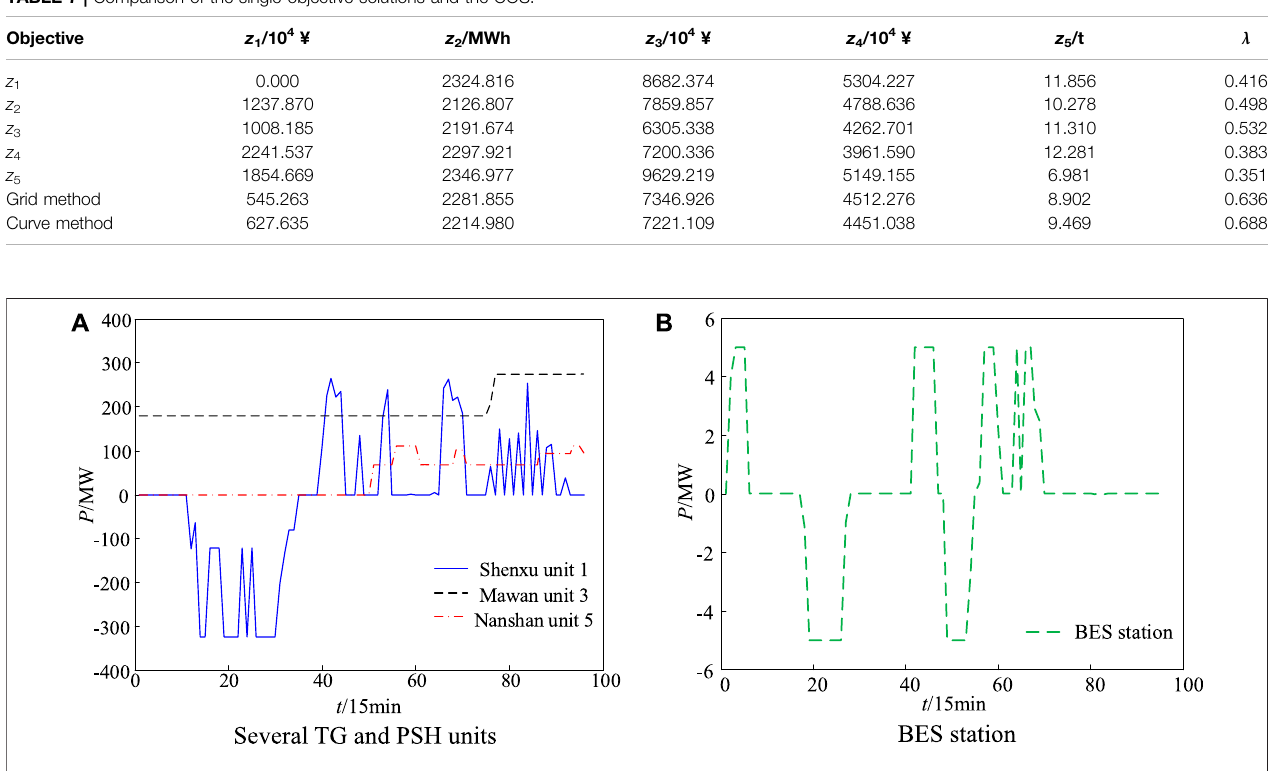
Frontiers in Energy Research |